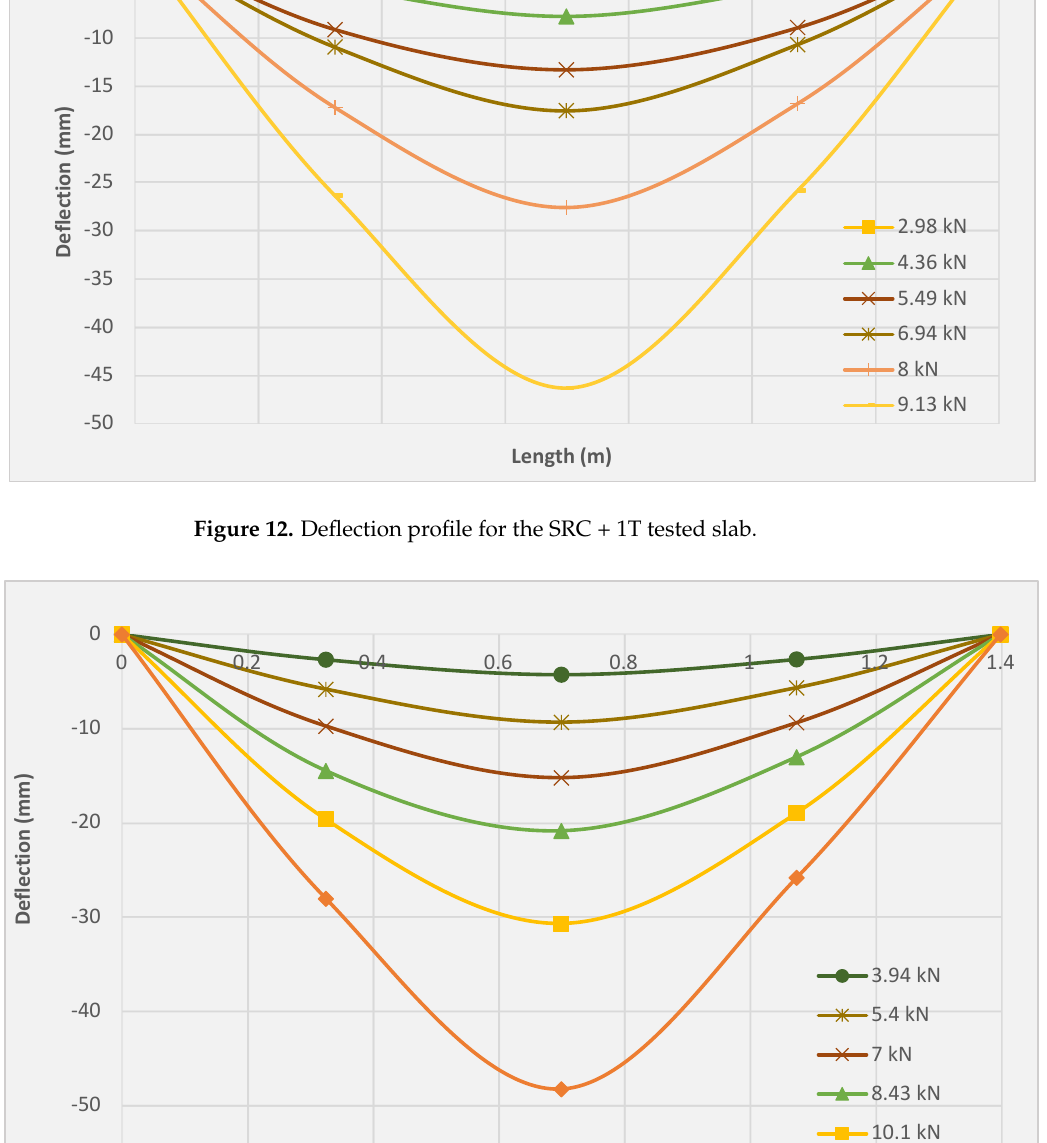
Figure 11. Deflection profile for the SRC tested slab.